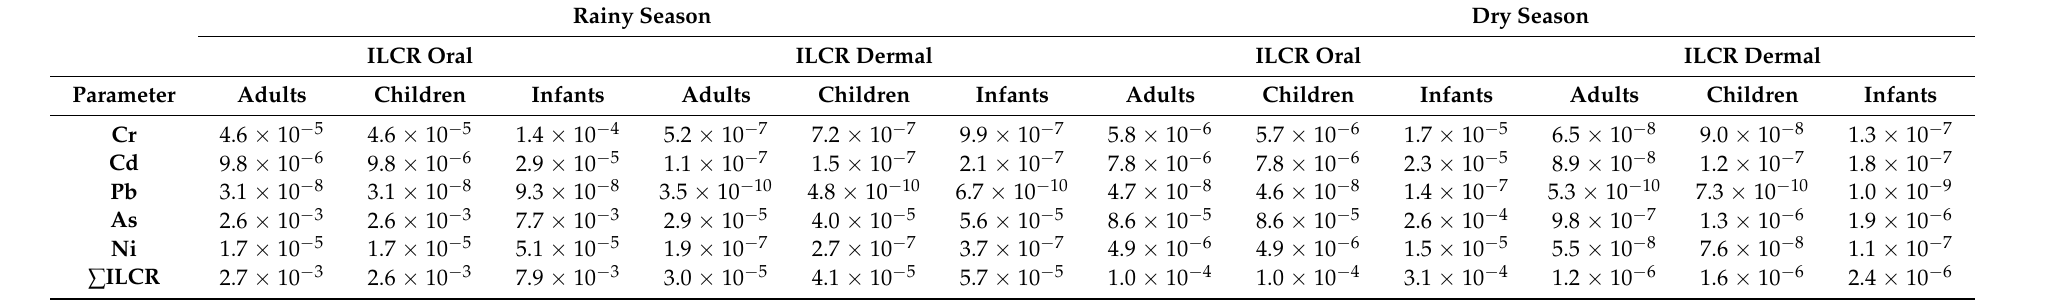
Table 7. Calculated incremental lifetime cancer risk (ILCR) values due to oral and dermal exposure of metals in